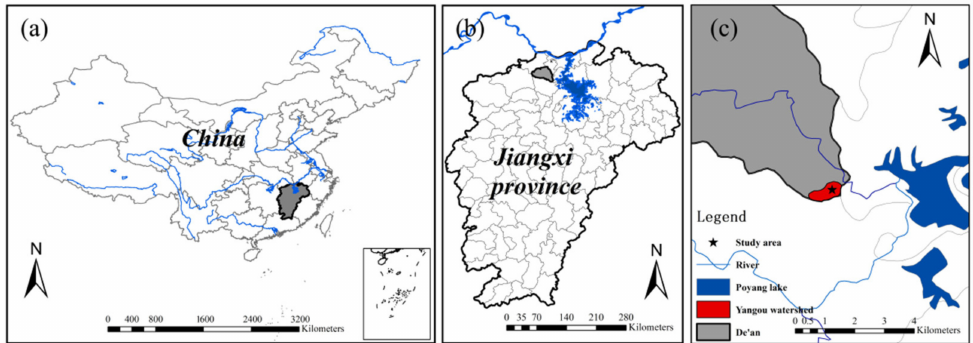
Figure 1. Location map of test area ( a ) Location of Jiangxi Province in China; ( b ) Location of De’an County in Jiangxi Province; ( c ) The location relationship between the test site and Yangou watershed, De’an County and Poyang Lake.